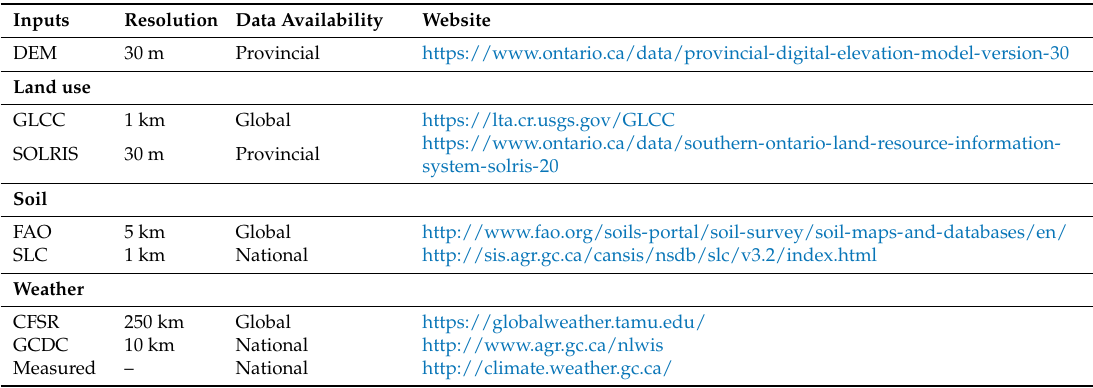
Table 1. Inputs used, their resolution, availability and website to download the